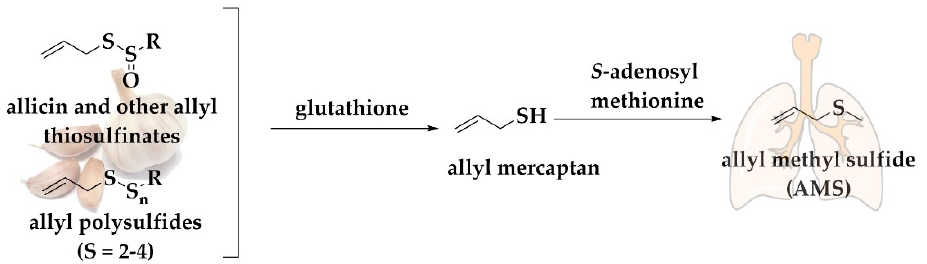
Figure 4. Generic pathway for the conversion of allyl thiosulfinates and polysulfanes to AMS. Allyl polysulfides are metabolized mainly to allyl methyl sulfide with allyl mercaptan as an intermediate, see text for details.